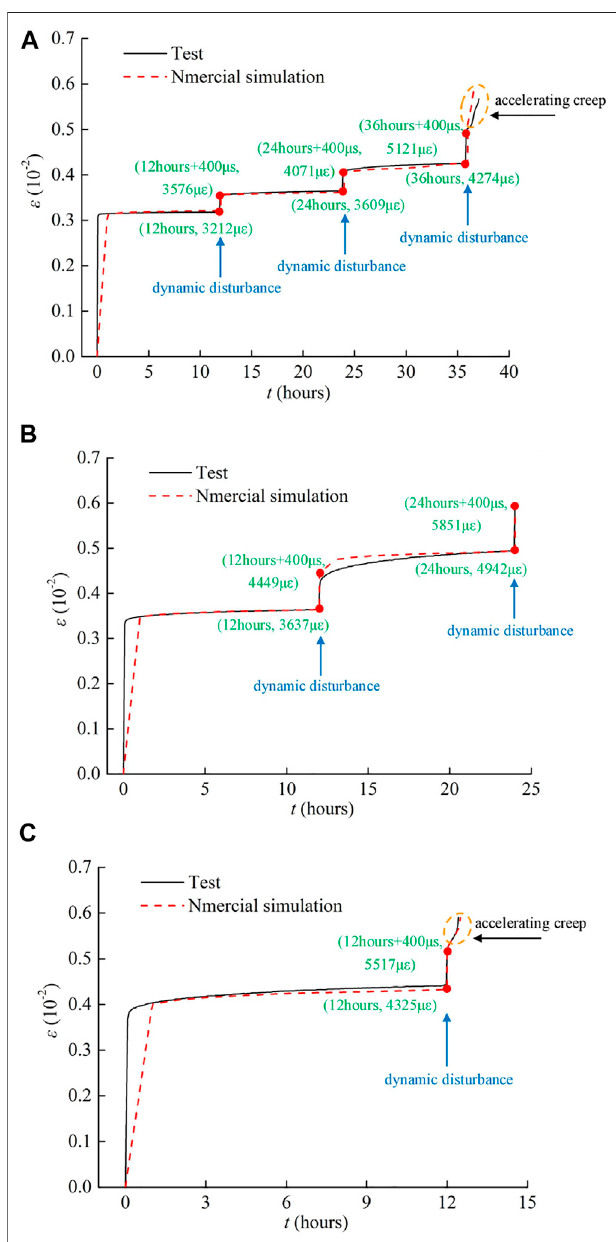
FIGURE 4 | Numerical and experimental results of rock under multi- stagecreeptestwithdynamicdisturbance: (A) creepstress=15.18 MPaand impact high=30 cm, (B) creepstress=17.71 MPaandimpact high=30 cm, (C) creep stress = 20.24 MPa and impact high = 30 cm.